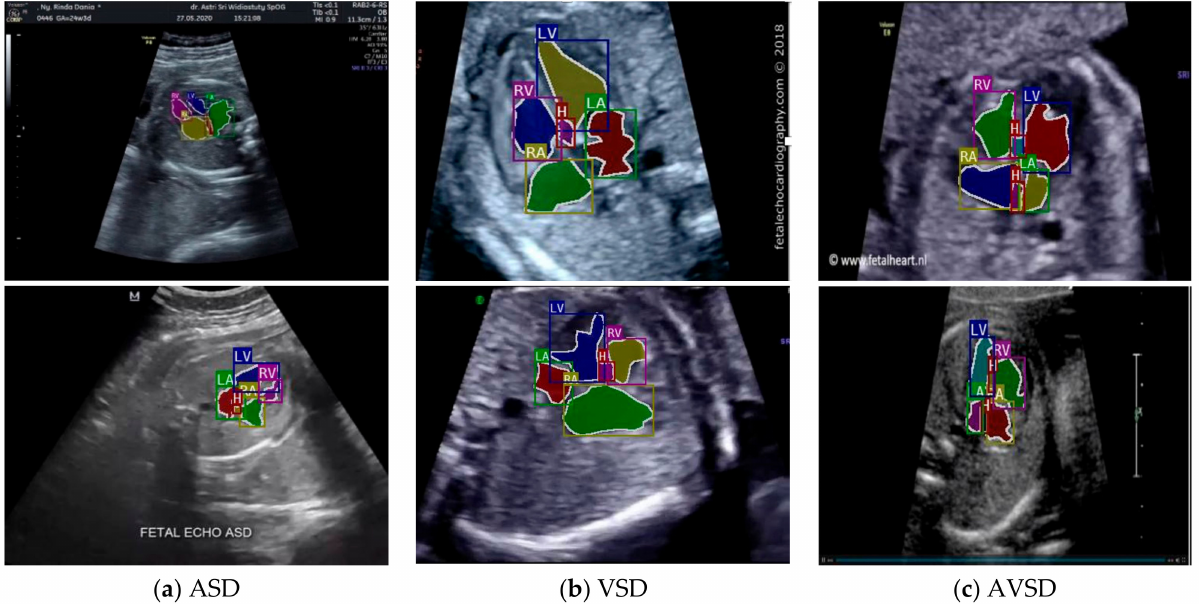
Figure 14. The sample result of wall-chamber segmentation with 4 CH view in ASD, VSD, and AVSD condition based on abnormal anatomy